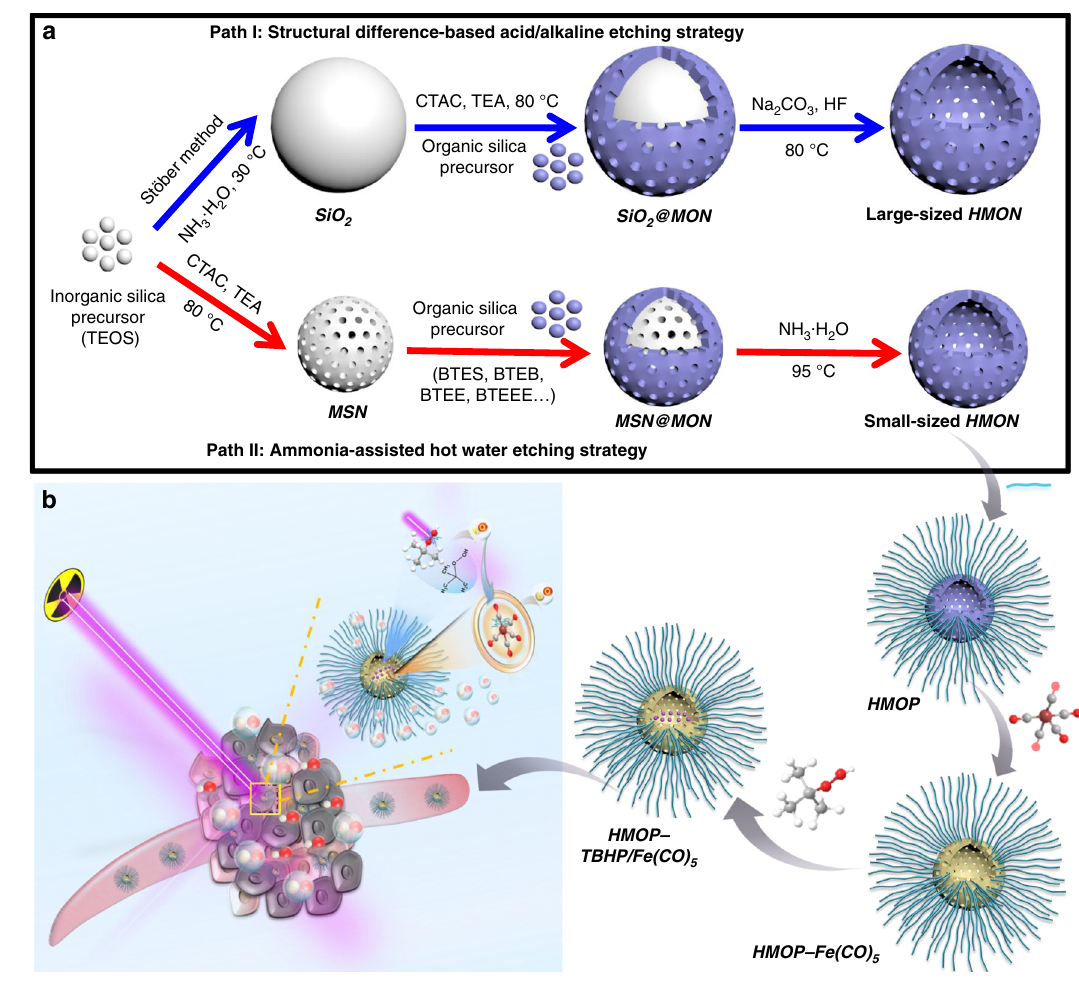
Fig. 1 Synthesis and biomedical application of HMOP-TBHP/Fe(CO) 5 . a Schematic of the different synthetic paths for large-sized HMON and small-sized HMON through a structural difference-based acid/alkaline etching strategy and an ammonia-assisted hot water etching strategy, respectively. Herein, a versatile method is fi rst proposed for the generic synthesis of a library of sub-50 nm HMONs with multiple framework hybridization of diverse organic moieties by changing only the introduced bissilylated organosilica precursors. b Schematic of the construction of HMOP-TBHP/Fe(CO) 5 for X-ray- activated synergistic radiodynamic/gas therapy. Through PEGylation and co-delivery of TBHP/Fe(CO) 5 by taking advantage of the hollow mesoporous structure of HMON, the cascaded generation of (cid:129) OH and CO molecules based on the X-ray-activated sequential bond cleavage will give rise to